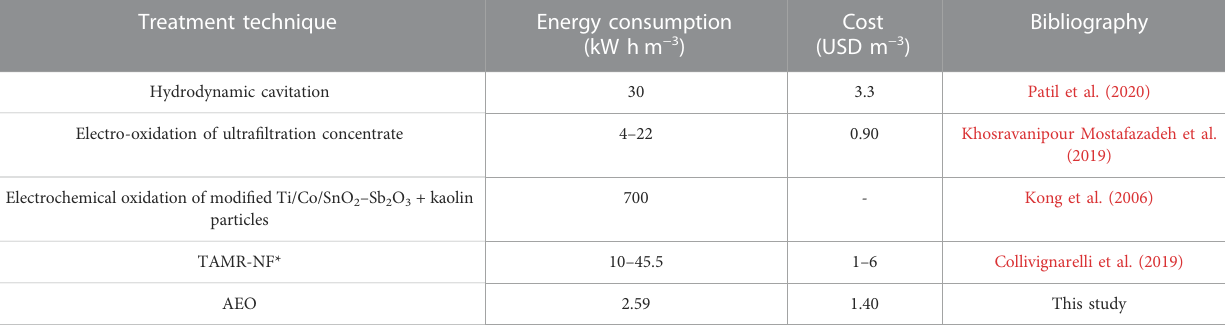
TABLE 2 Energy consumption and operating costs involved in the removal of surfactants by different technologies. Treatment